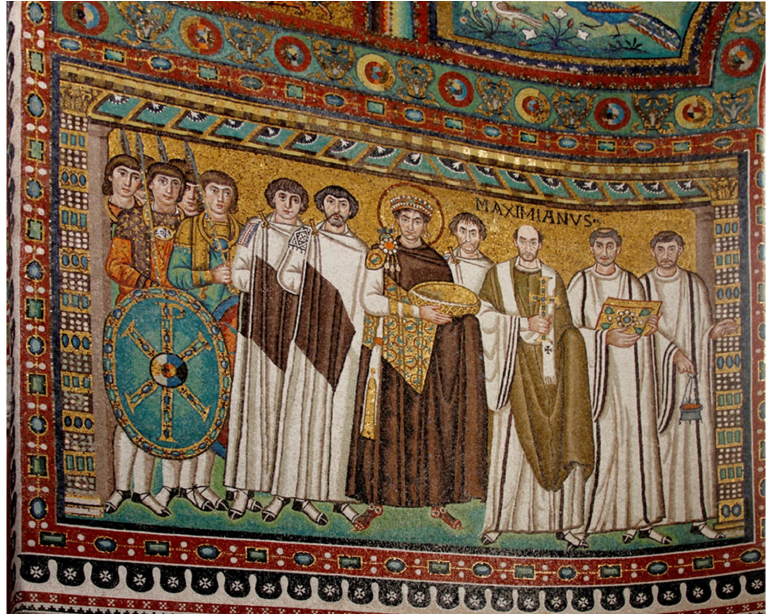
Figure 13. Mosaic depicting Emperor Justinian and his attendants, 6th century CE. Byzantine; Basilica of San Vitale, Ravenna. © José Luiz Bernardes Ribeiro. Digital image available under Creative